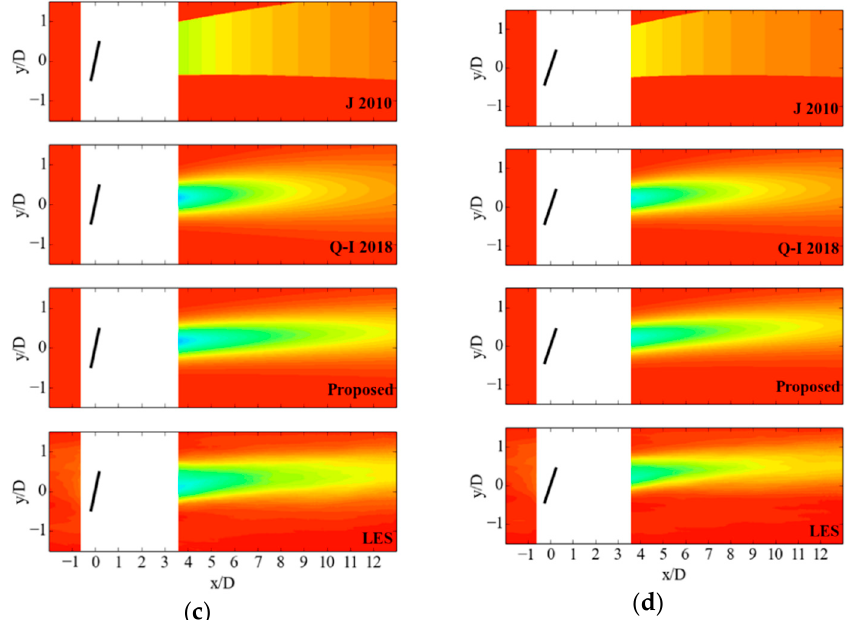
Figure 10. Contour plots of normalized mean streamwise velocity in the horizontal plane at hub height for different yaw angles: ( a ) γ = 0°; ( b ) γ = 10°; ( c ) γ = 20°; ( d ) γ = 30°. The black solid lines denote the wind turbine rotors.